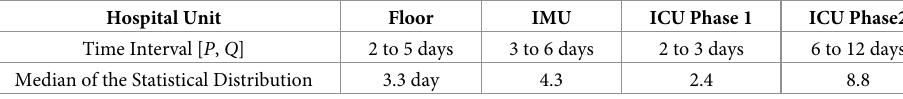
Table 2. Time window for the patient stay at each stage in reference to the workflow of Fig 1.